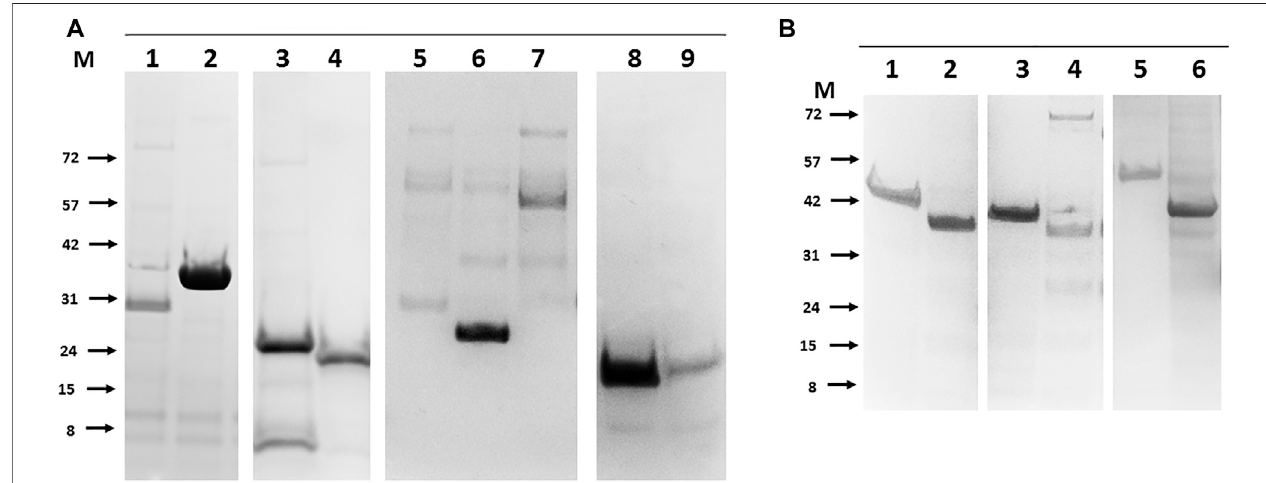
FIGURE4| Rescueofsolublepuri fi edrecombinantbTBproteinsthatwereoriginallypoorlyexpressedbyalternatepositioningoftheHistag.Panel (A) .Examplesof N-terminal tagged proteins puri fi ed from E.coli . 1- Mb3338 (31 kDa), 2-Mb2656 (31 kDa), 3-Mb2898 (22 kDa), 4-Mb2900 (19 kDa), 5-Mb0130 (34 kDa), 6-Mb0854 (31 kDa), 7- Mb1656 (53 kDa), 8-Mb3652 (18 kDa), 9-Mb3871 (20 kDa). Panel (B) . Examples of N-terminal tagged proteins puri fi ed from insect cells. 1- Mb0977_Mb3046c (43 kDa), 2-Mb0959 (39 kDa), 3-Mb1319 (44 kDa), 4-Mb3070 (37 kDa), 5-Mb2244 (53 kDa), 6-Mb1228 (39 kDa). Molecular weight markers (M) are labelled to the left of each panel and are in kilodaltons.